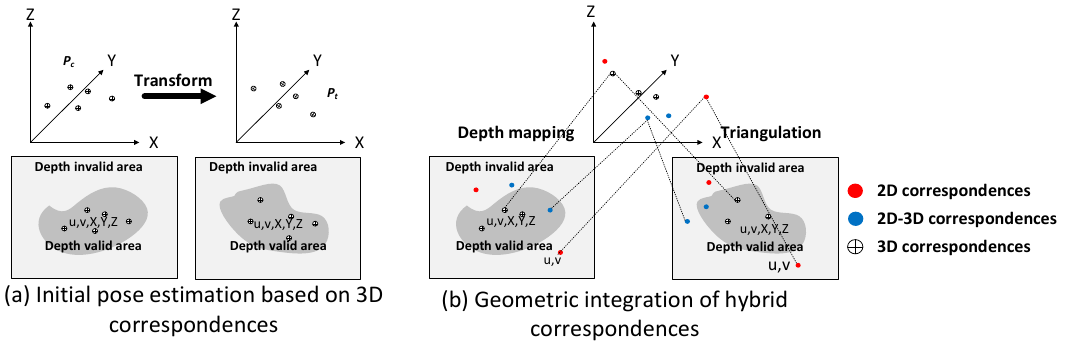
Figure 2. ( a ) Initial pose estimation based on 3D correspondences; ( b ) Geometric integration of hybrid correspondences.